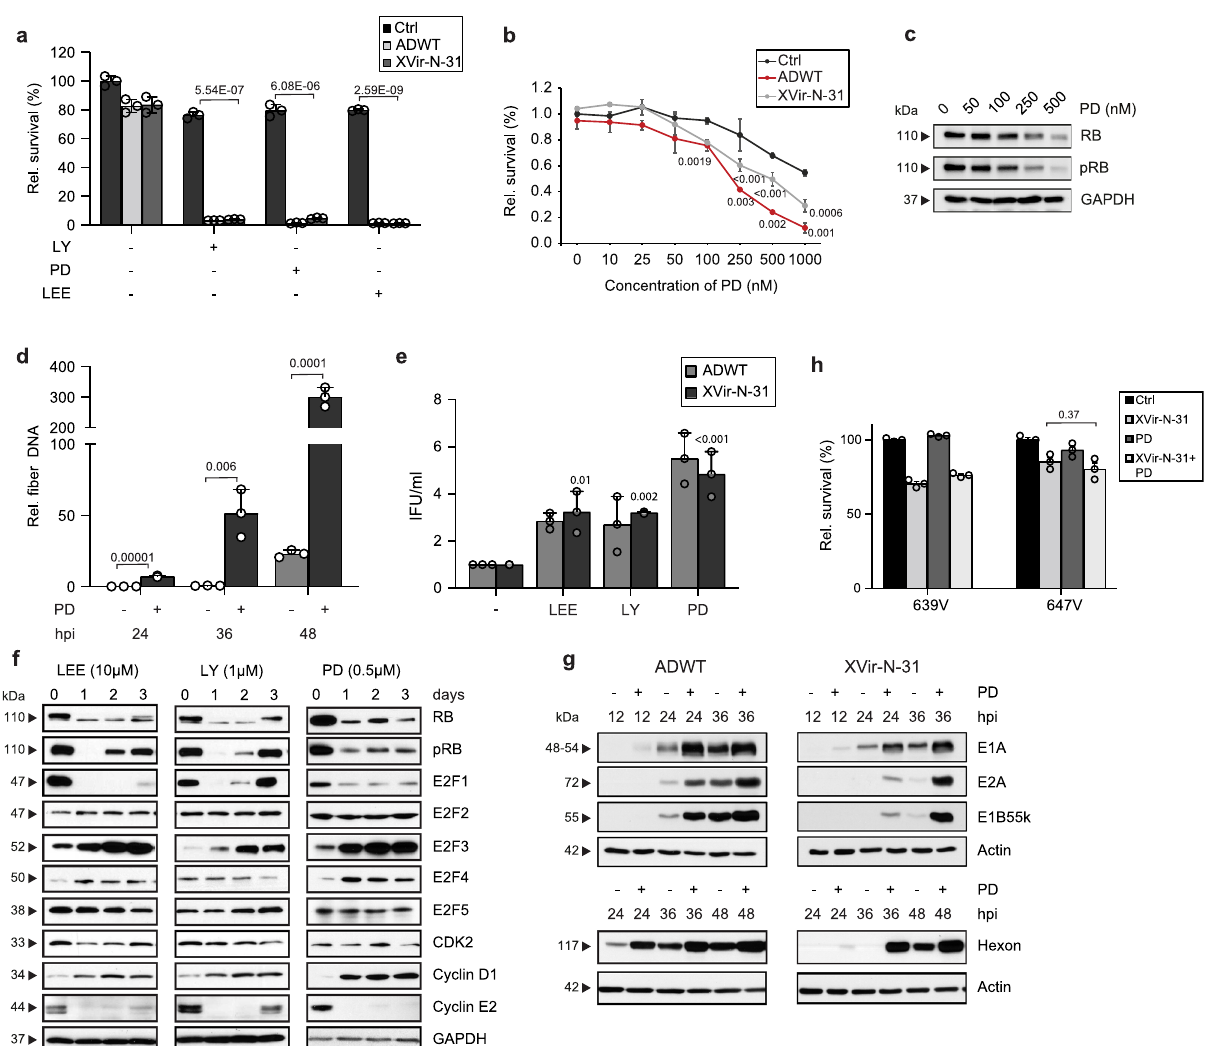
Fig. 2 | Combination with CDK4/6 inhibition enhances oncolytic virotherapy. a , b CellproliferationanalysesinRBpositiveT24cells. a T24cellswerepre-treated for 24h with CDK4/6 inhibitors as indicated and infected with ADWT (MOI 80) or XVir-N-31 (MOI 60). b T24 cells were treated with increasing concentrations of Palbociclibfor 24h and infected with ADWT (MOI50) and XVir-N-31(MOI50). Cell viability was assessed at 4dpi. Data are shown as the percentage of surviving